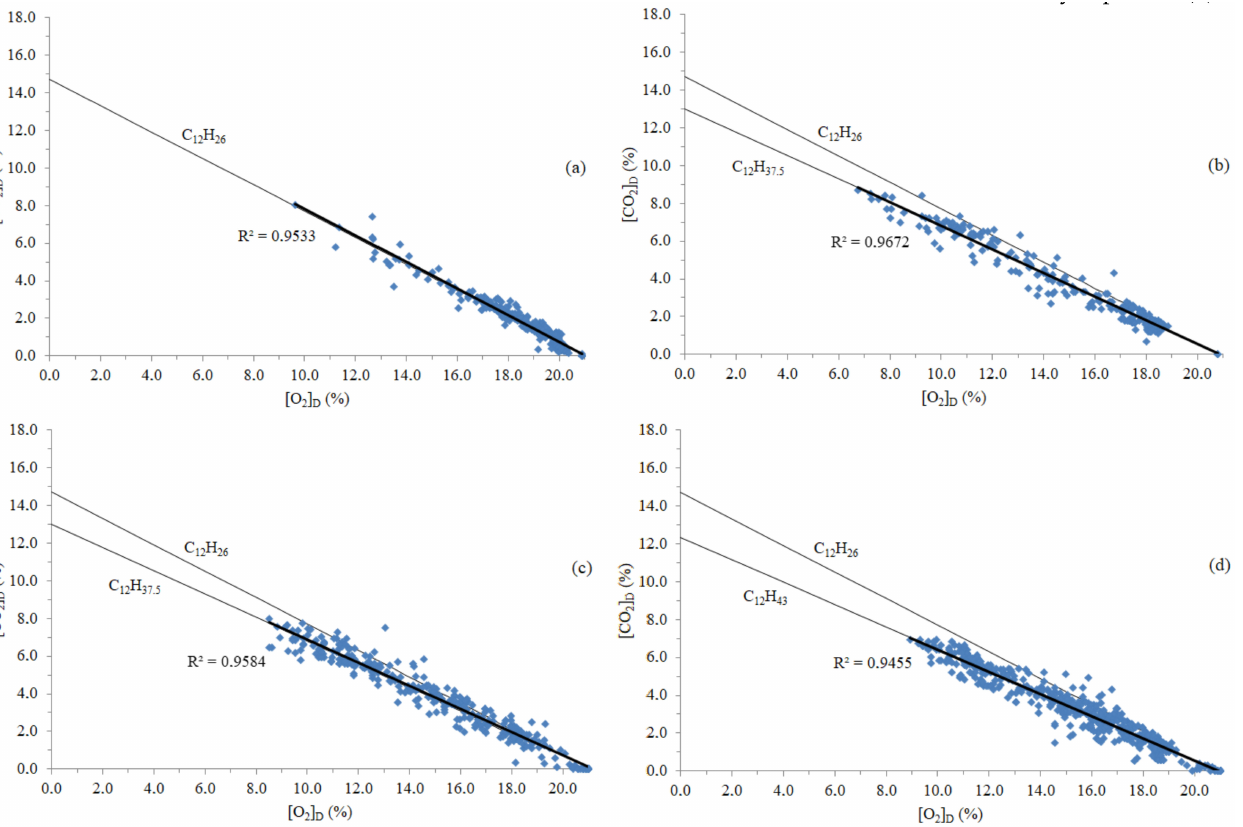
Figure 4. CO 2 concentration as function of O 2 concentration, both on a dry basis, for the combustion of diesel fuel in all trucks: #1 ( a ), #2 ( b ), #3 ( c ), and #4 ( d ).